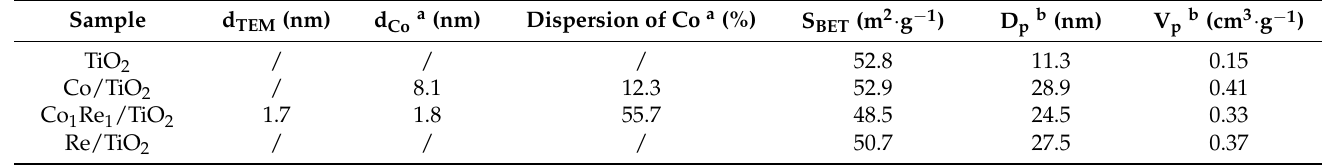
Table 1. Textural properties of TiO 2 , Co/TiO 2 , Re/TiO 2 and Co 1 Re 1 /TiO 2 .